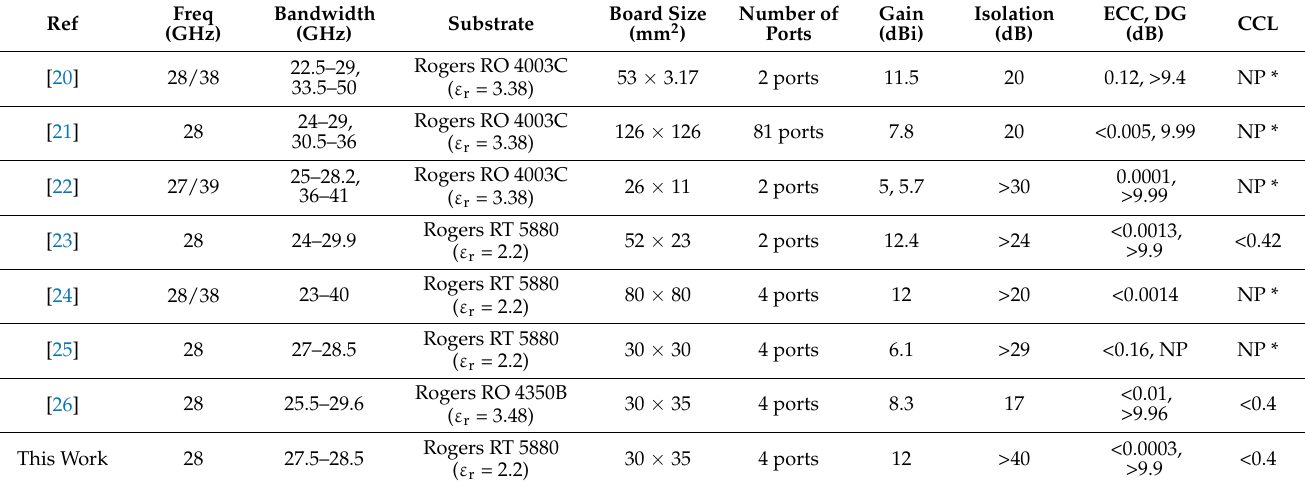
Table 3. Performance comparison with related works.